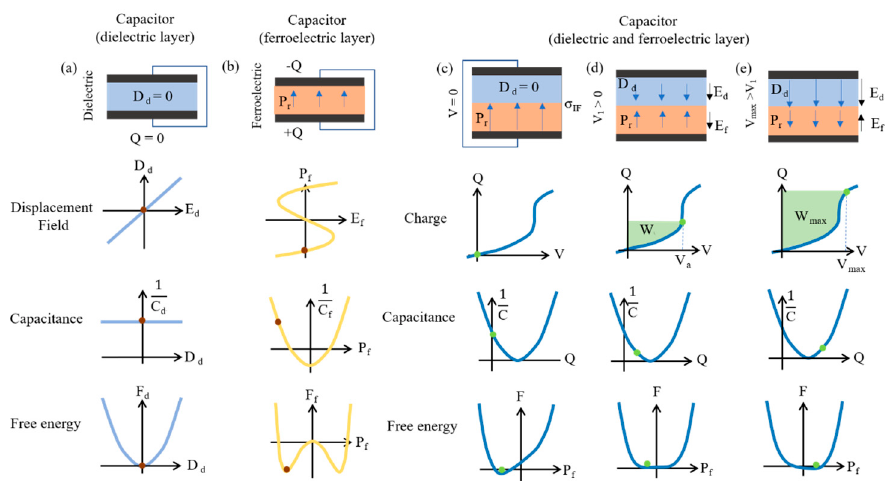
Figure 8. Illustrations and plots to express the integration of capacitance caused by both the dielectric layer and the ferroelectric layer to enhance capacity. ( a ) Schematic of the dielectric capacitor including D d - E d curve, C d − 1 D d c-urve, and F d - D d curve without external bias. ( b ) Schematic of ferroelectric